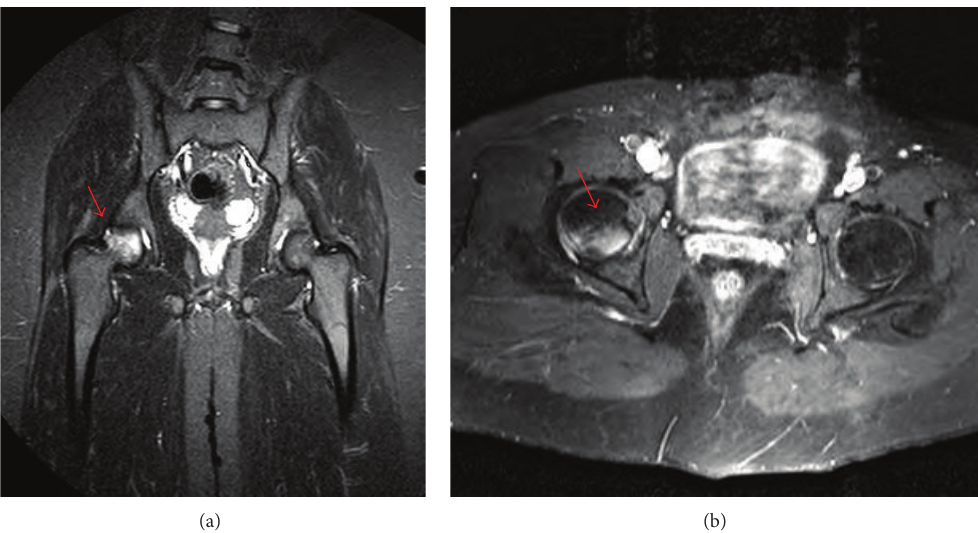
Figure 2: Hip MRI (a) coronal view and (b) axial view. A subcortical wedge shaped enhancing area ( arrows ) with adjacent bone marrow edema in the right femoral head posterior articular